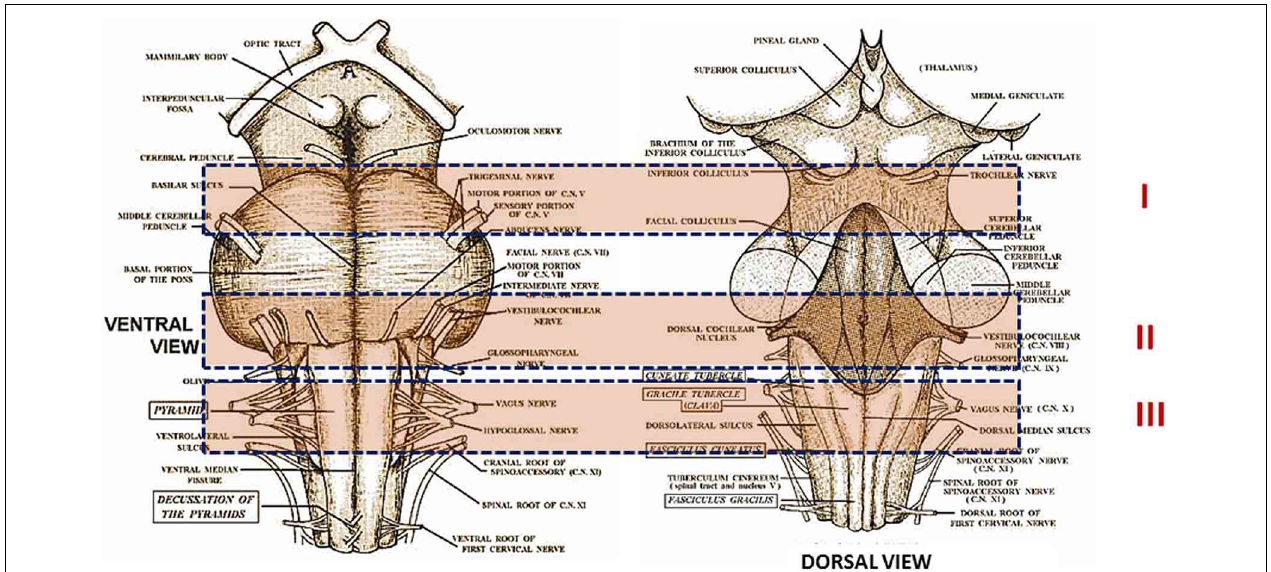
FIGURE 1 | Schematic representation of the brainstem sampling. On the left: ventral surface; on the right: dorsal surface. I, ponto-mesencephalic specimen, including the upper third of the pons and the adjacent portion of mesencephalon; II, medullar-pontine specimen, extending from the